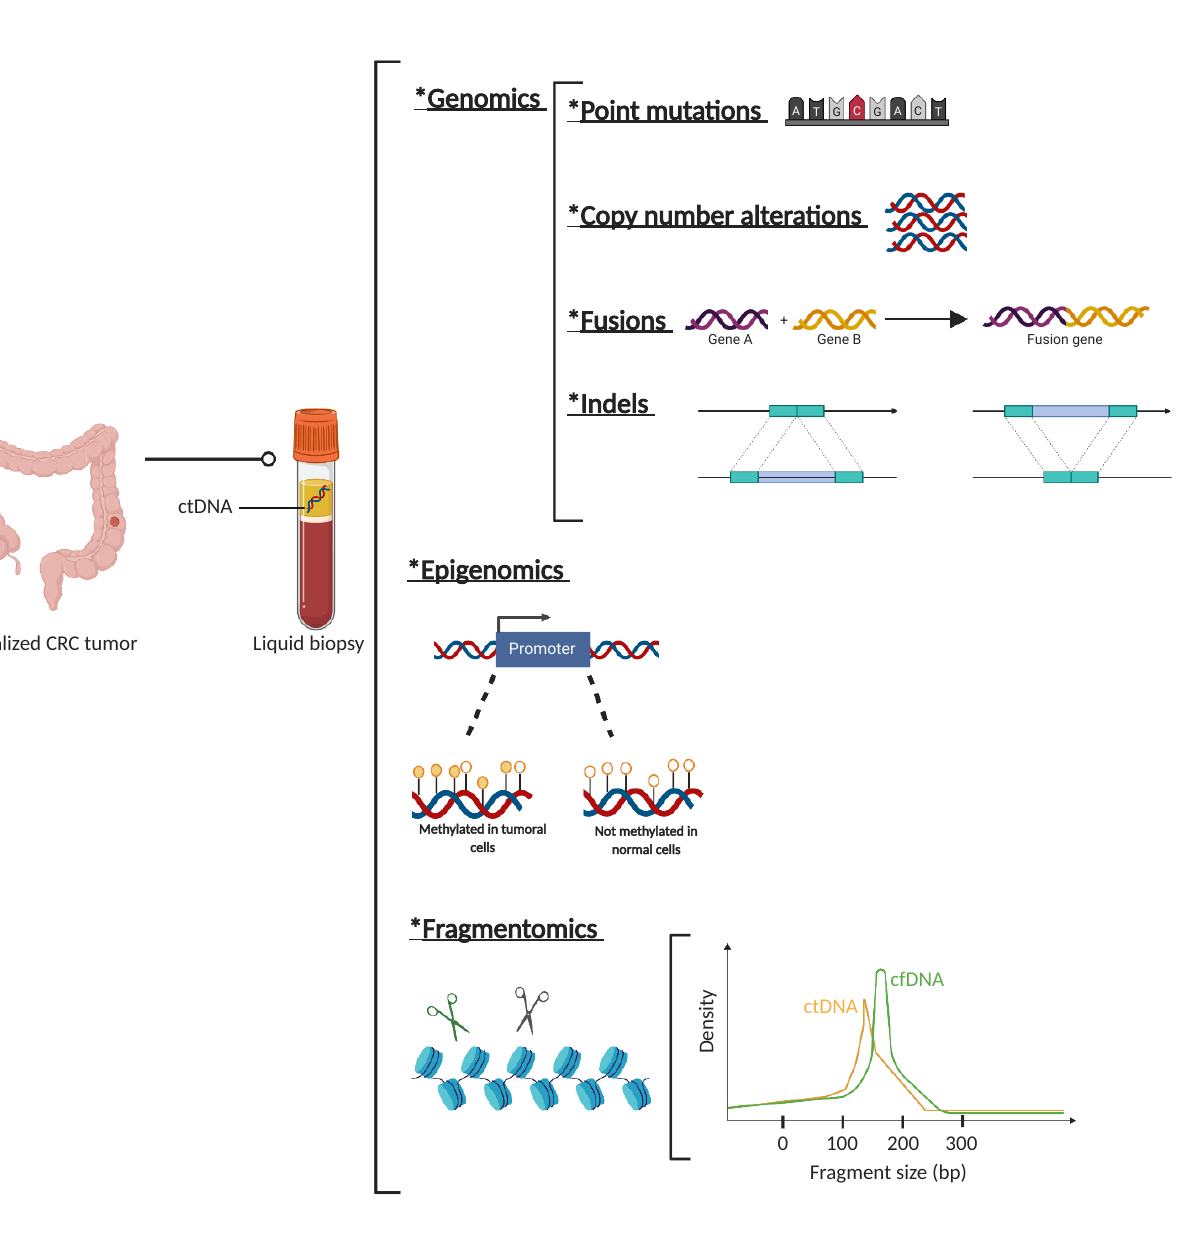
Figure 2. Circulating tumor (ct)DNA features. Description of genetic, epigenetic, and fragmentomic alterations that can be found in plasma cell free DNA analysis. *: The asterisks are placed as a way of listing the different